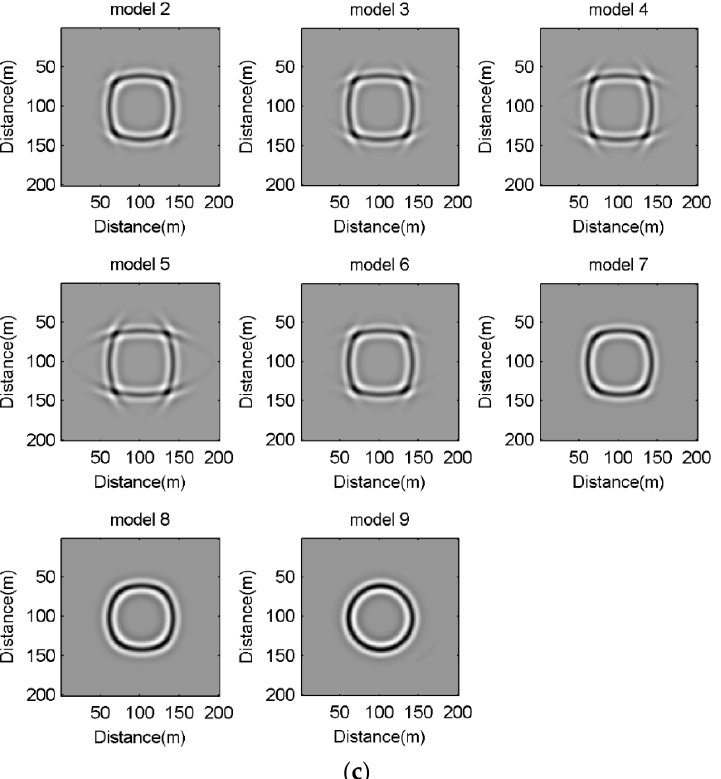
Figure 14. Snapshots of wave fields at 0.05 s. ( a ) Radial concentrated force source. ( b ) Vertical concentrated force source. ( c ) Shear source.